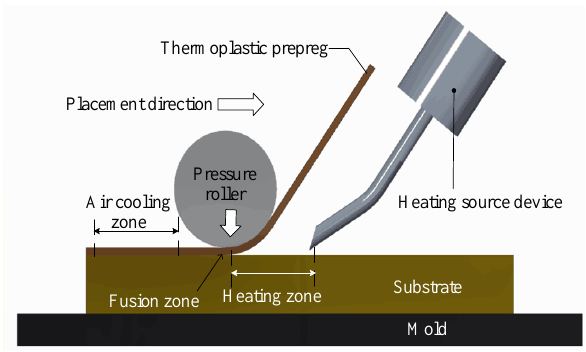
Figure 1. Schematic diagram of automatic thermoplastic fiber placement.